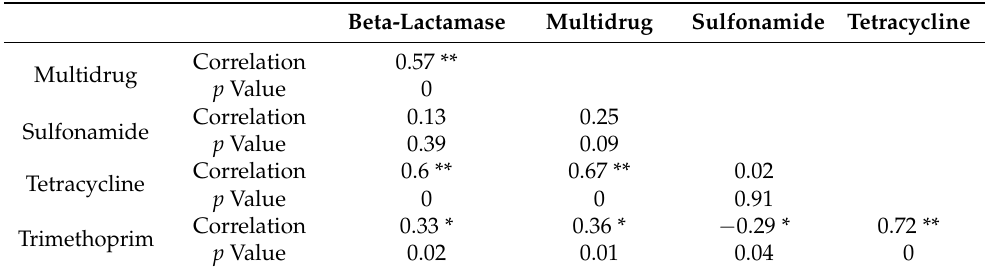
Table A5. Spearman (cid:48) s rank correlation coefficient and the significance between ARG classes.